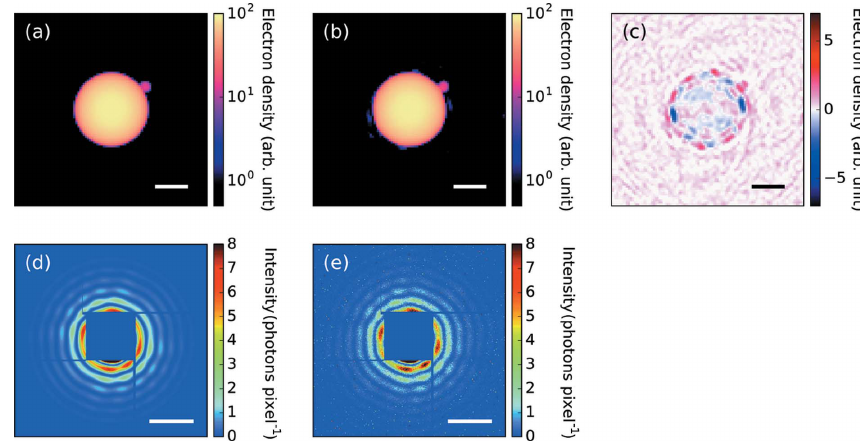
Figure 7 Result of the structure reconstruction from the measured diffraction pattern [Fig. 1( c )] using the implemented algorithm. ( a ) A projection of a sphere with a small sphere used as the initial estimate of the density map. The initial estimate of the density map was constructed from the optimization result shown in Fig. 2. ( b ) The reconstructed density map by the implemented algorithm. ( c ) The difference between ( a ) and ( b ) defined as ( b ) (cid:4) ( a ). ( d ) The simulated pattern from ( a ). ( e ) The simulated pattern from ( b ). The scale bars in ( a )–( c ) are 100 nm and those in ( d )–( e ) are 0.1 nm (cid:4) 1 .